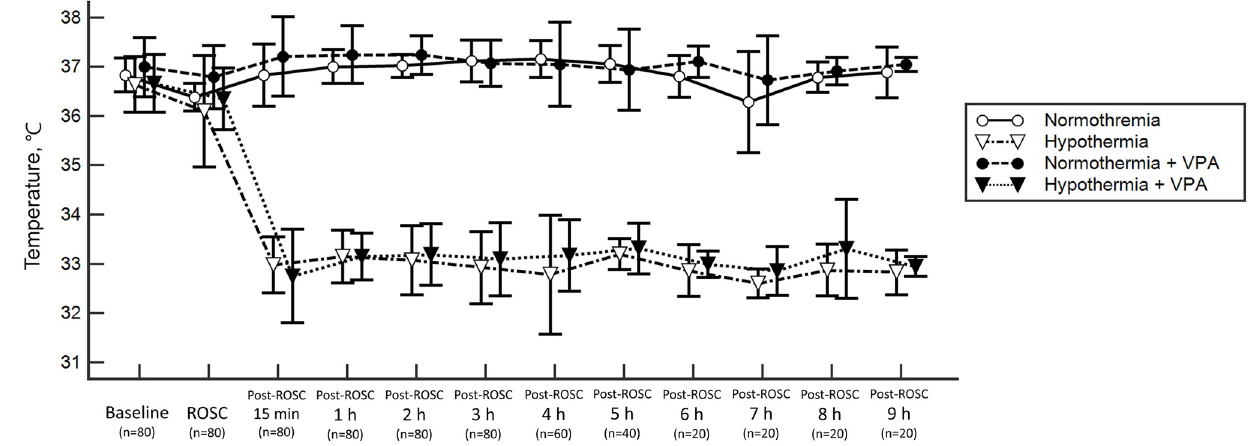
Fig 2. Experimental temperature control. Temporal temperature changes in four treatment groups.